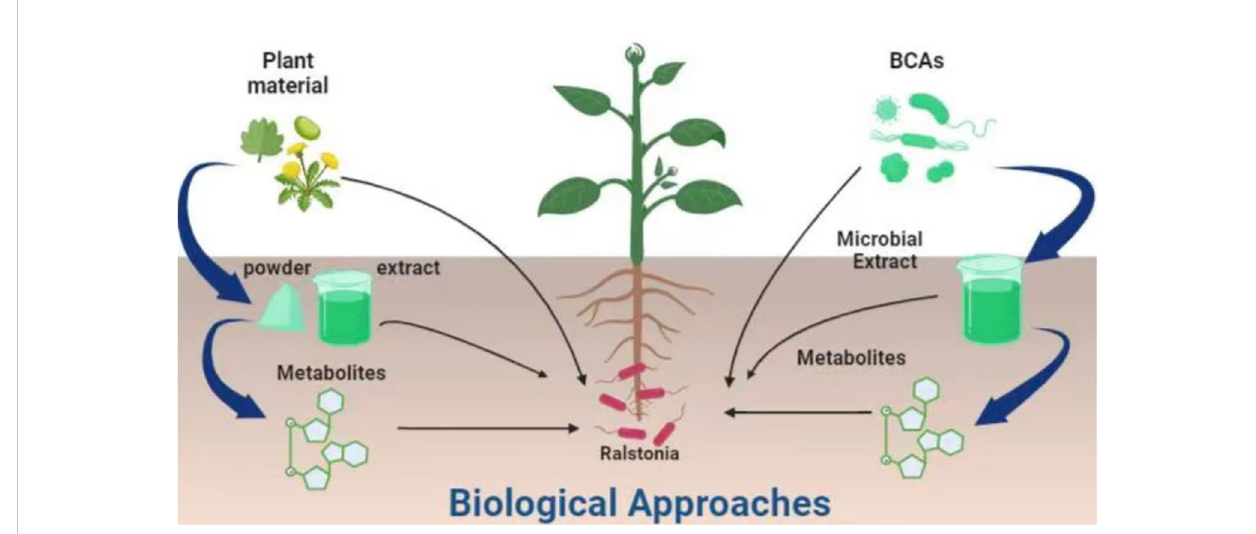
FIGURE 2 Biological approaches used for the management of R. solanacearum . IDM, Integrated Disease